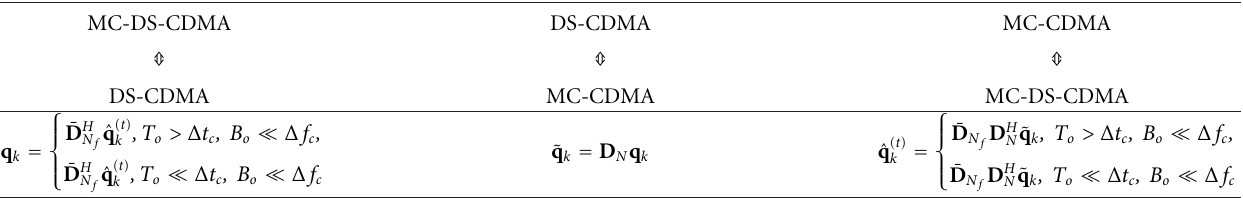
Table 5: Summary of equivalence results for a TFS channel—Part 2. T o and B o refer to the duration and bandwidth of MC-DS-CDMA basis